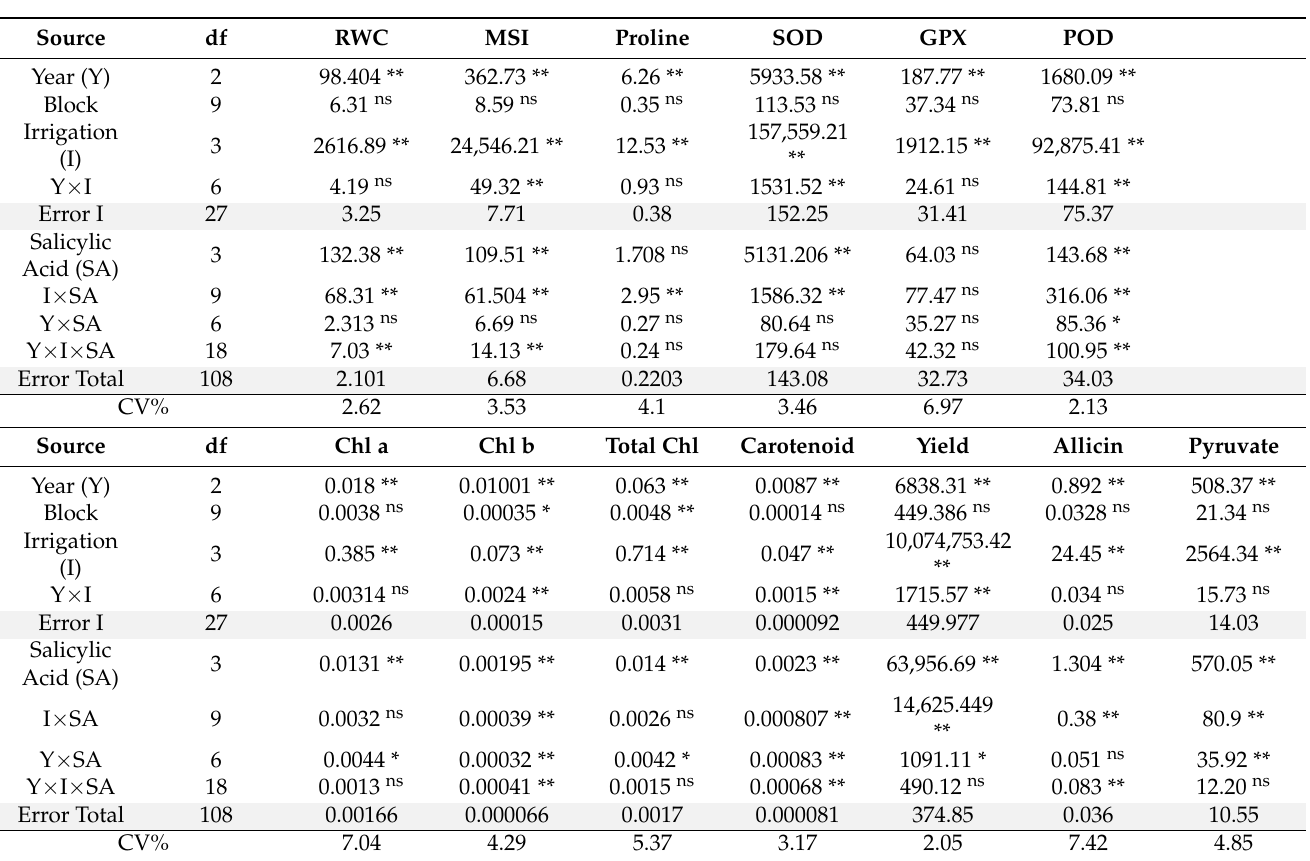
Table 1. Combined analysis of variance of the studied physiological traits in A. hirtifolium under the influence of different levels of irrigation and foliar application with salicylic acid during three years of experiment (2016, 2017, and